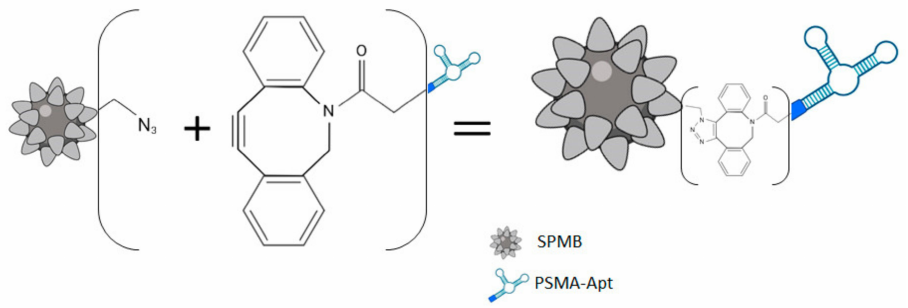
Figure 3. Scheme of SPMB–PSMA–Apt complex